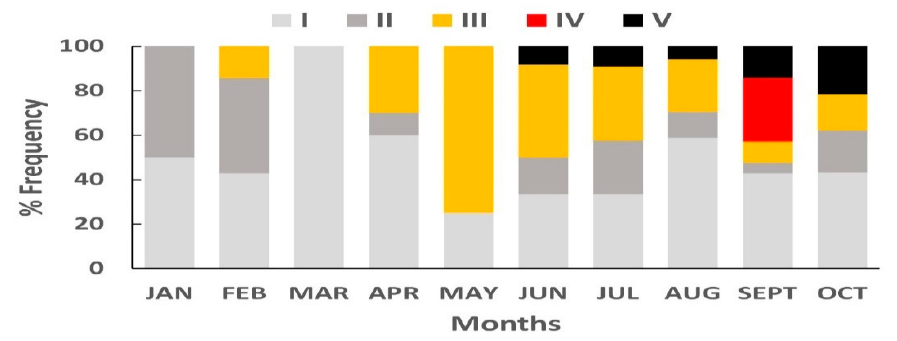
Figure 6. Monthly (January–October) ovarian stages (I–V, according to Hard [60]) of the blue crab Callinectes sapidus in Monolimni Lagoon and the adjacent coastal